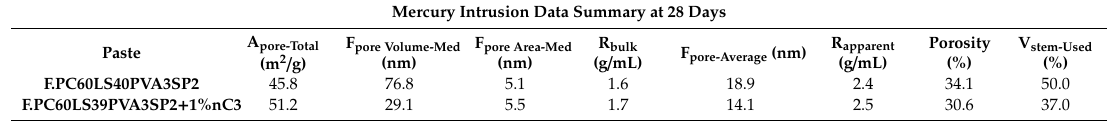
Table 5. Mercury intrusion data summary comparison of F.PC60LS40PVA3SP2 and F.PC60LS39PVA3SP2+1%nC3.